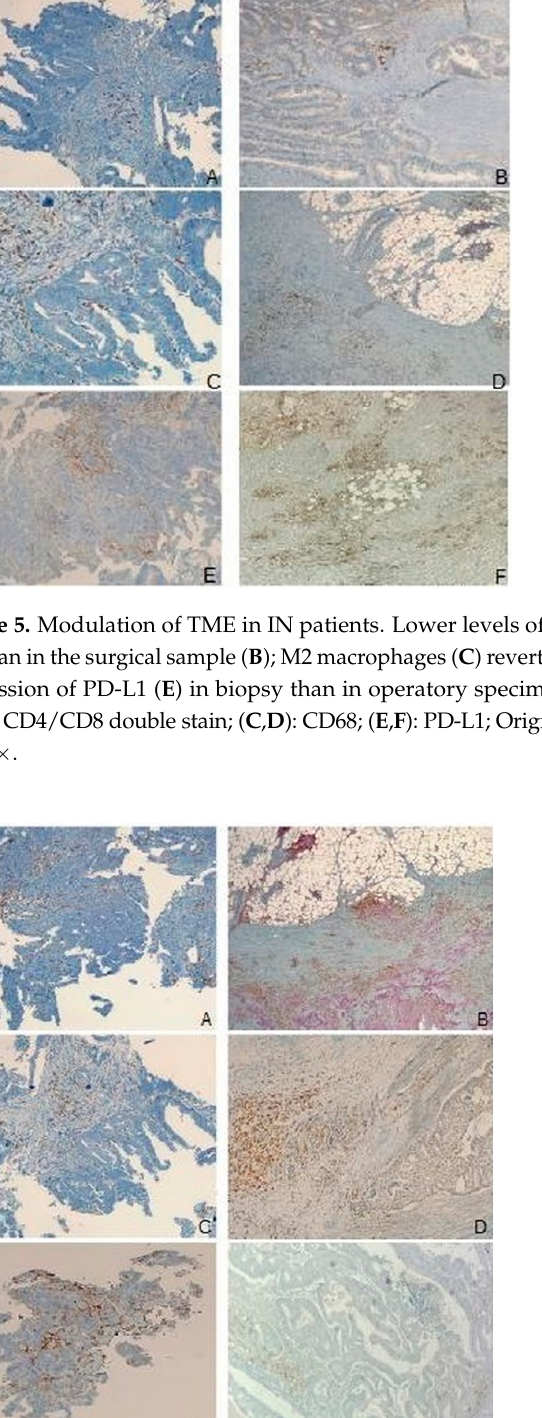
Figure 4. Modulation of TME of patients receiving IN from biopsy to surgical specimen. A , T ‐ exh lymphocytes; B , T ‐ reg cells; C , TAM; D , PD ‐ L1 expression. The differences were statistically significant for all cells evaluated ( p < 0.05).